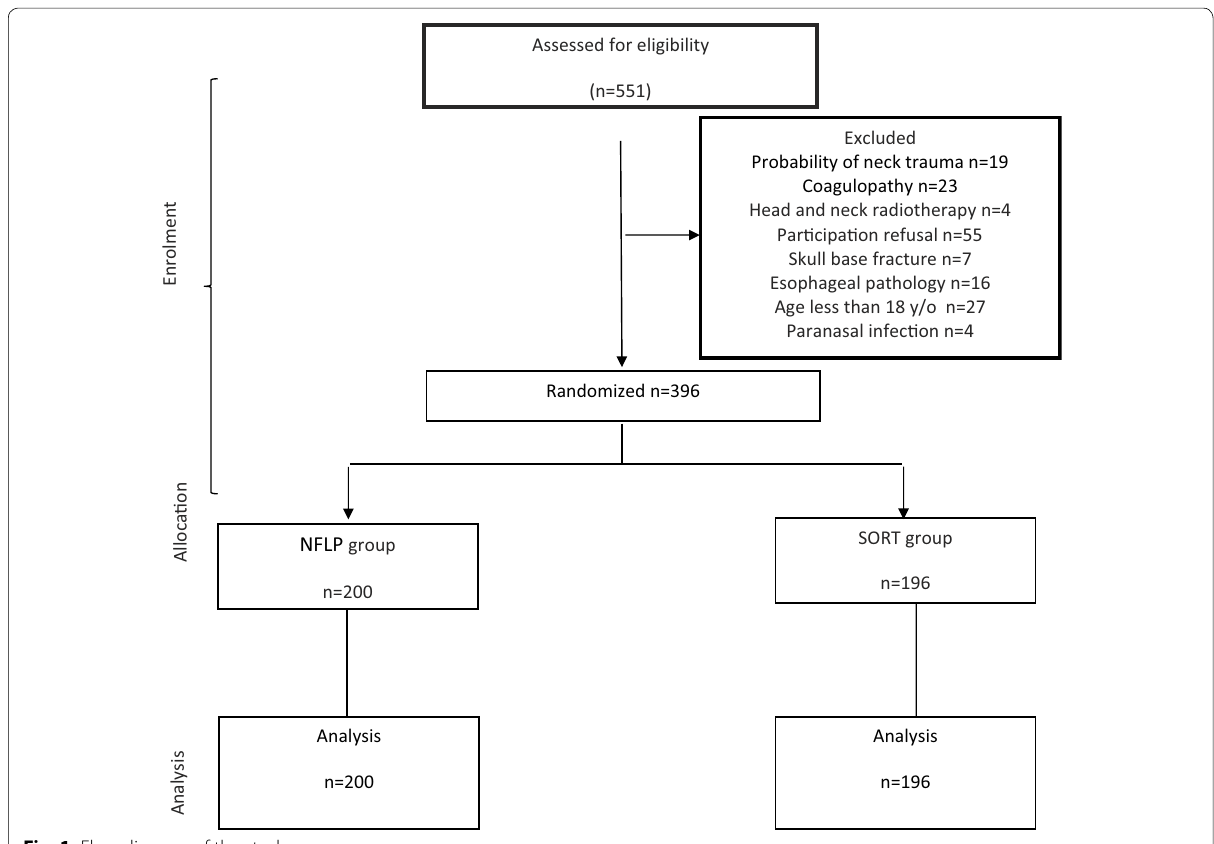
Fig. 1 Flow diagram of the